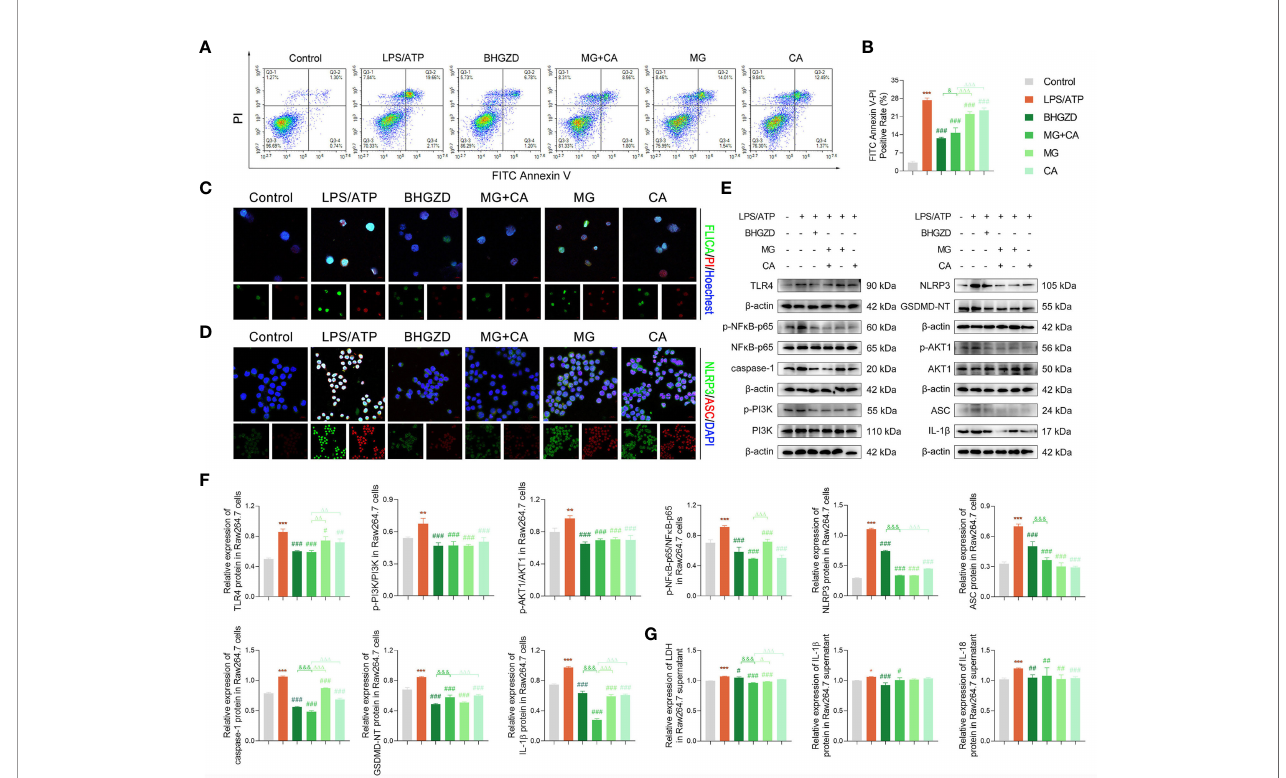
FIGURE 5 | BHGZD inhibits LPS/ATP-induced pyroptosis in RAW264.7 macrophage by downregulating TLR4, p-PI3K/PI3K, p-AKT1/AKT1, p-NF k B-p65/NF k B-p65, NLRP3, ASC, caspase-1, GSDMD-NT, IL-1 b , and IL-18 (Control, AIA-M, BHGZD, MG+CA, MG, and CA). (A, B) Flow cytometry analysis for Annexin V/PI staining in RAW264.7 cells ( n ≥ 3 per group, all experiments were performed in triplicate). (C) Representative images of FAM-FLICA Casapse-1 that binds only to activated caspase-1 (scale bar represents 50 m m, FAM-FLICA green, PI red, Hoechst blue). (D) Expression of NLRP3 and ASC protein measured by immuno fl uorescent staining and confocal microscopy in RAW264.7 cells (scale bar represents 50 m m, NLRP3 FITC green, ASC CY3 red, DAPI blue). (E, F) Expression levels of TLR4, p-PI3K/PI3K, p-AKT1/AKT1, p- NF k B-p65/NF k B-p65, NLRP3, ASC, caspase-1, GSDMD-NT, and IL-1 b in RAW264.7 cells measured by Western blotting ( n = 3 per group). (G) Levels of IL-1 b , IL-18, and LDH release in RAW264.7 cells detected by ELISA ( n ≥ 3 per group, all experiments were performed in triplicate). *, **, ***, p < 0.05, p < 0.01, p < 0.001, respectively, comparison with the normal control group; #, ##, ###, p < 0.05, p < 0.01, p < 0.001, respectively, comparison with LPS/ATP-induced model; &, &&&, p < 0.05, p < 0.001, comparison with the treatment of BHGZD; △ , △△ , △△△ , p < 0.005, p < 0.01, p < 0.001, comparison with the treatment of the two-BAC